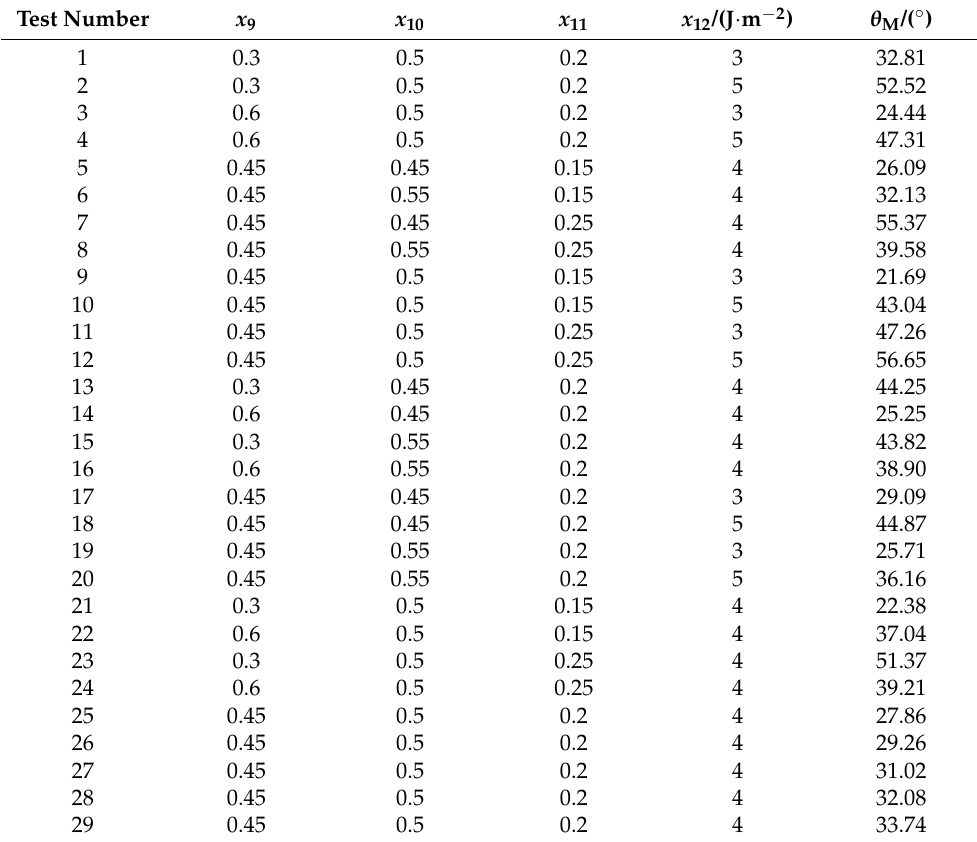
Table 9. Design matrix and results of the BBD test for θ M .